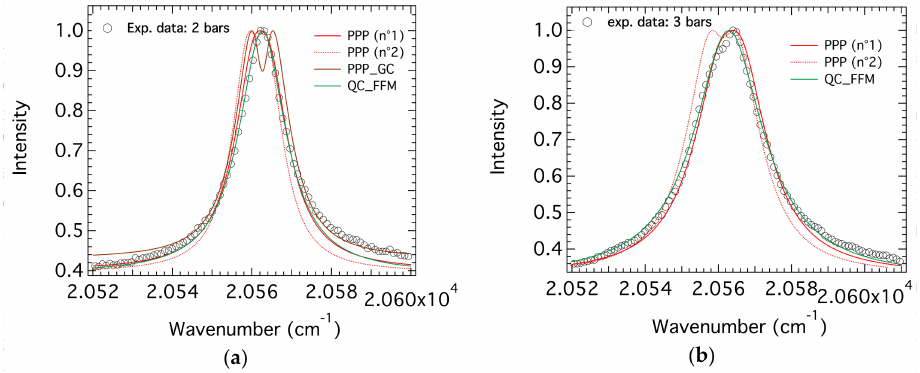
Figure 13. The comparison/fitting of the intermediate pressure H- β spectra. ( a ) P = 2 bars; ( b ) P = 3 bars. The contributions are similar to those of Figure